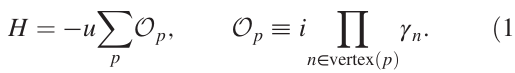
FIG. 1. We consider a honeycomb lattice with (a) a single Majorana fermion on each lattice site, so the O product of the six Majorana fermions on the vertices of a hexagonal plaquette. The colored plaquettes in (b) correspond to the three distinct bosonic excitations that may be obtained by violating a plaquette